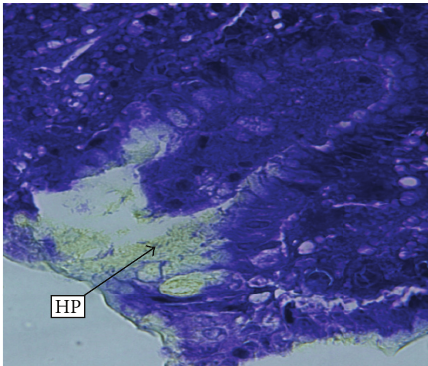
Figure 1: Vacuolising lesions of the foveolar epithelium. Numerous HP ( H. pylori ) colonies are visible in the foveolar mucus. (Alcian yellow stain; 40x magnification.)